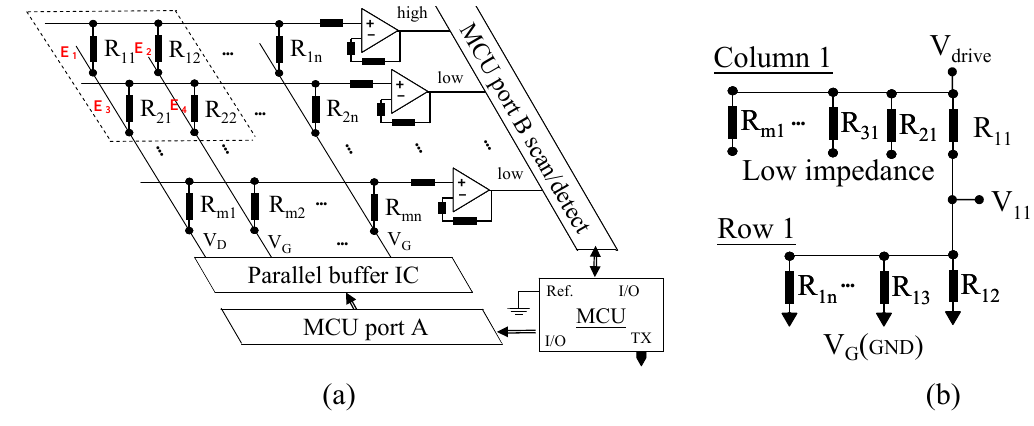
Figure 2. Schematic circuit of a flexible array sensor for use in multi-touch sensing applications, (a) Control system frame, and (b) the equivalent circuit of row 1 when columns inputs are 1,0, …,